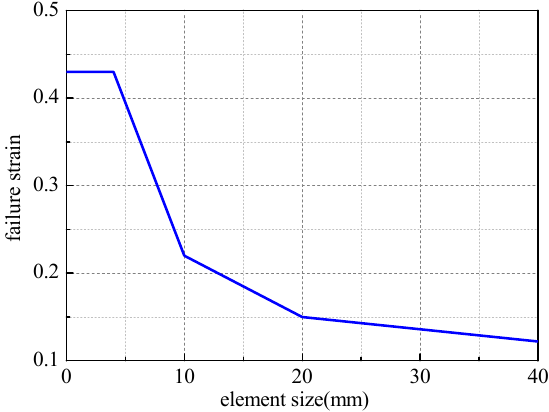
Figure 5. The relationship between the element size and failure strain. Table 4. The rigid body material parameters.